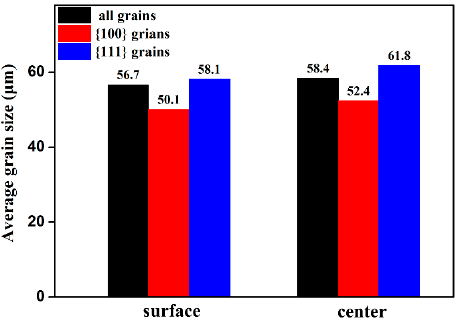
( b ) center layer. Metals 2019 , 9 , x FOR PEER REVIEW